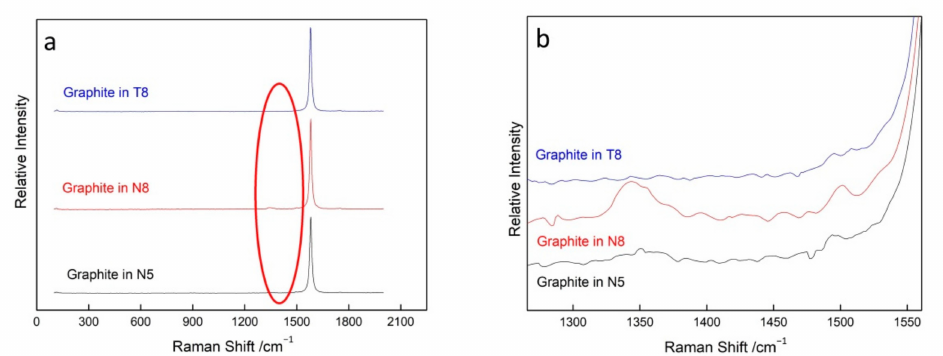
Figure 9. ( a ) Micro-Raman spectra of graphite inclusions in tanzanite samples N5, N8, and T8; ( b ) micro-Raman spectra of graphite inclusions in samples N5, N8, and T8 in the range of 1300–1500 cm − 1